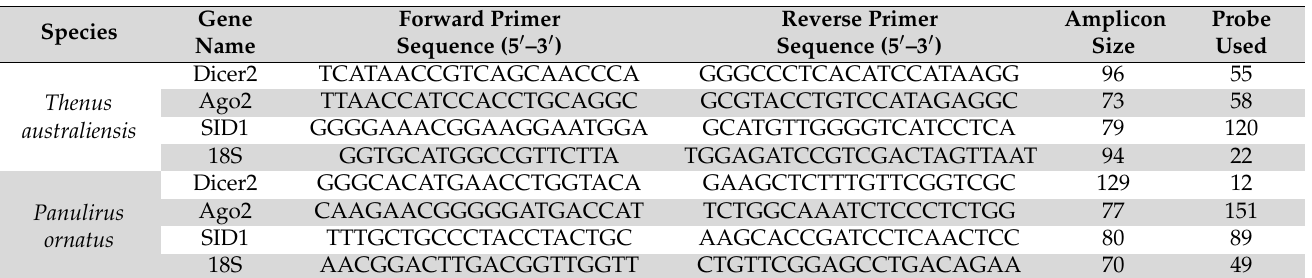
Table 2. List of primers used for qPCR and respective